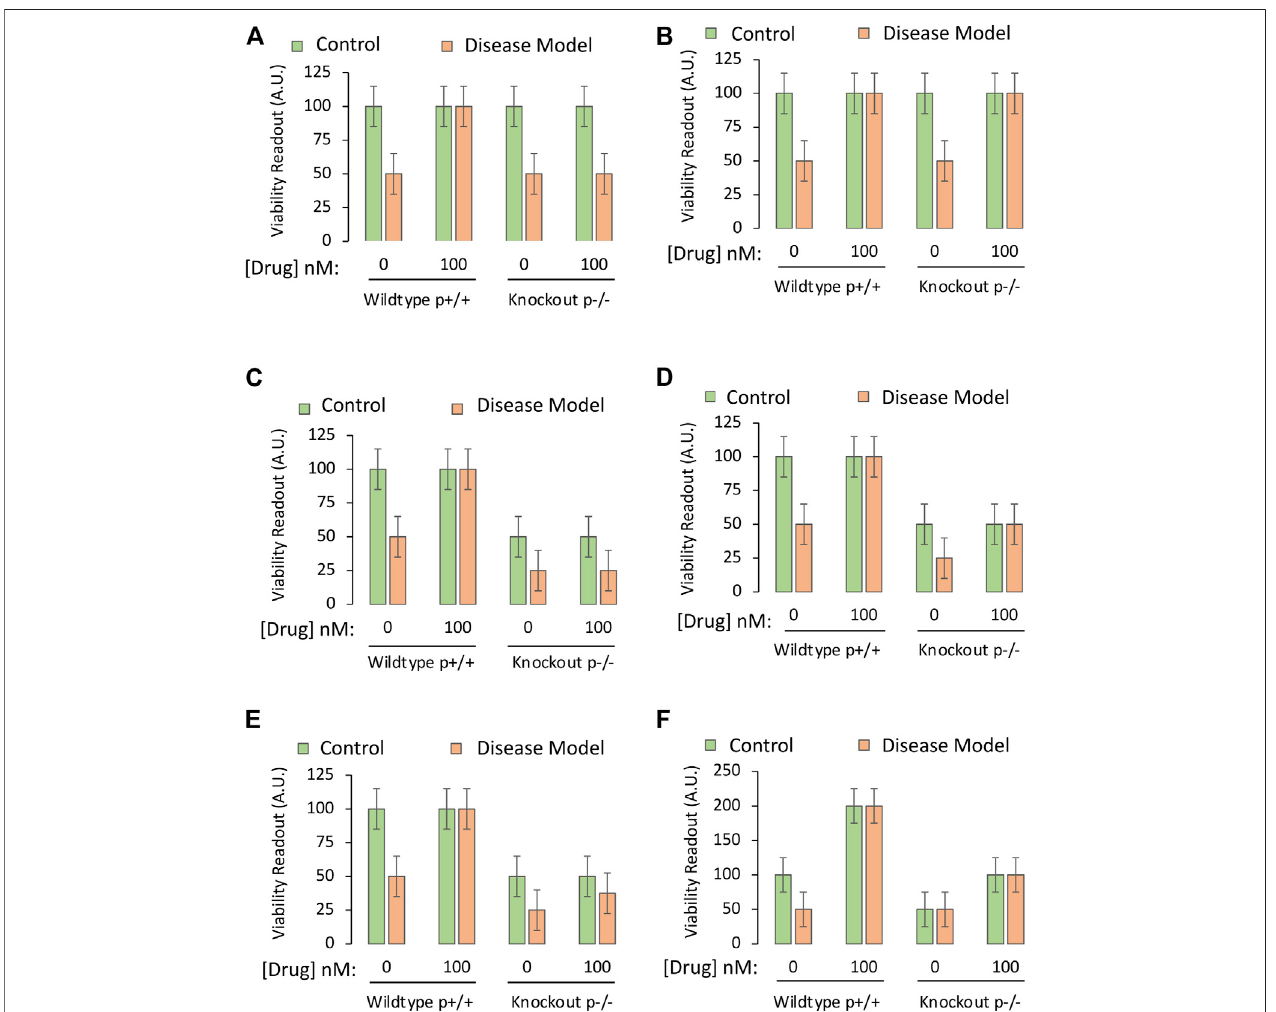
FIGURE3| Testing themechanistichypothesisbyleveragingknockoutofthe geneencoding aproteinthatisupregulatedbythe drug. Aspeci fi cand sensitivecell culture-based viability assay is used to screen whether the drug candidate exerts its protective impact by engaging the protein of interest. The Y axes re fl ect cellular viability levels (the dependent variable), and the X axes indicate the fi rst two independent variables: 1) Application of vehicle or the most protective concentration of the drug (as determined in Part I of this series), and 2) use of primary cells harvested from wildtype mice (cells with both alleles, labeled as p+/+) or homozygous mice with knockout of the gene encoding the protein (both alleles absent, labeled as p − / − ). The orange and green bars refer to the third independent variable, the disease model or the non-diseased control, respectively. (A) The protective impact of the drug candidate is abolished when the gene coding for the protein is knocked out. (B) Knocking out the gene does not modify the protective impact of the drug candidate. (C) Knocking out the gene reduces basal viability under physiological conditions (green bars) and also abolishes the protective impact of the candidate drug under disease conditions (orange bars). (D) Knocking out the gene reduces basal viability under physiological conditions (green bars), but does not abolish, or even reduce, the protective impact of the candidate drug. (E) Knocking out the gene reduces baseline viability under physiological conditions and also partially dampens the protective impact of the candidate drug under disease conditions. (F) . Practice example for active learning; see text for